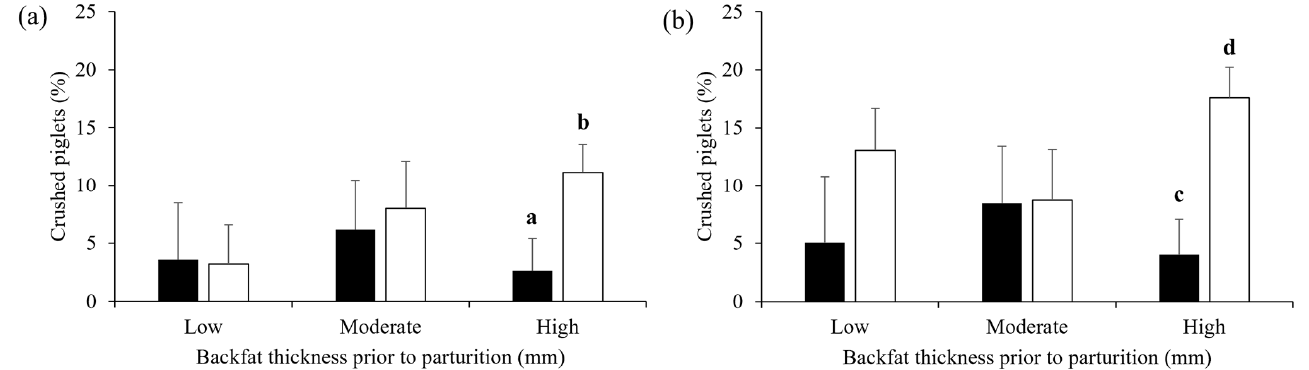
Figure 4. Preweaning mortality of piglets from litters raised either in the crate system (black bar) or the free-farrowing system (white bar) from sows of three different backfat classes before farrowing, low (<18 mm), moderate (18 to 24 mm) and high (>24 mm). ( a ) Between 0 to 3 days of age and ( b ) between 0 to 21 days of age. Data are presented as Lsmeans and SEM. a and b superscripts indicate a tendential difference ( p = 0.055). c and d superscripts indicate a significant difference ( p < 0.05). Table 4. Causes of piglet mortality during the lactation period in the crate system and the free- farrowing system.